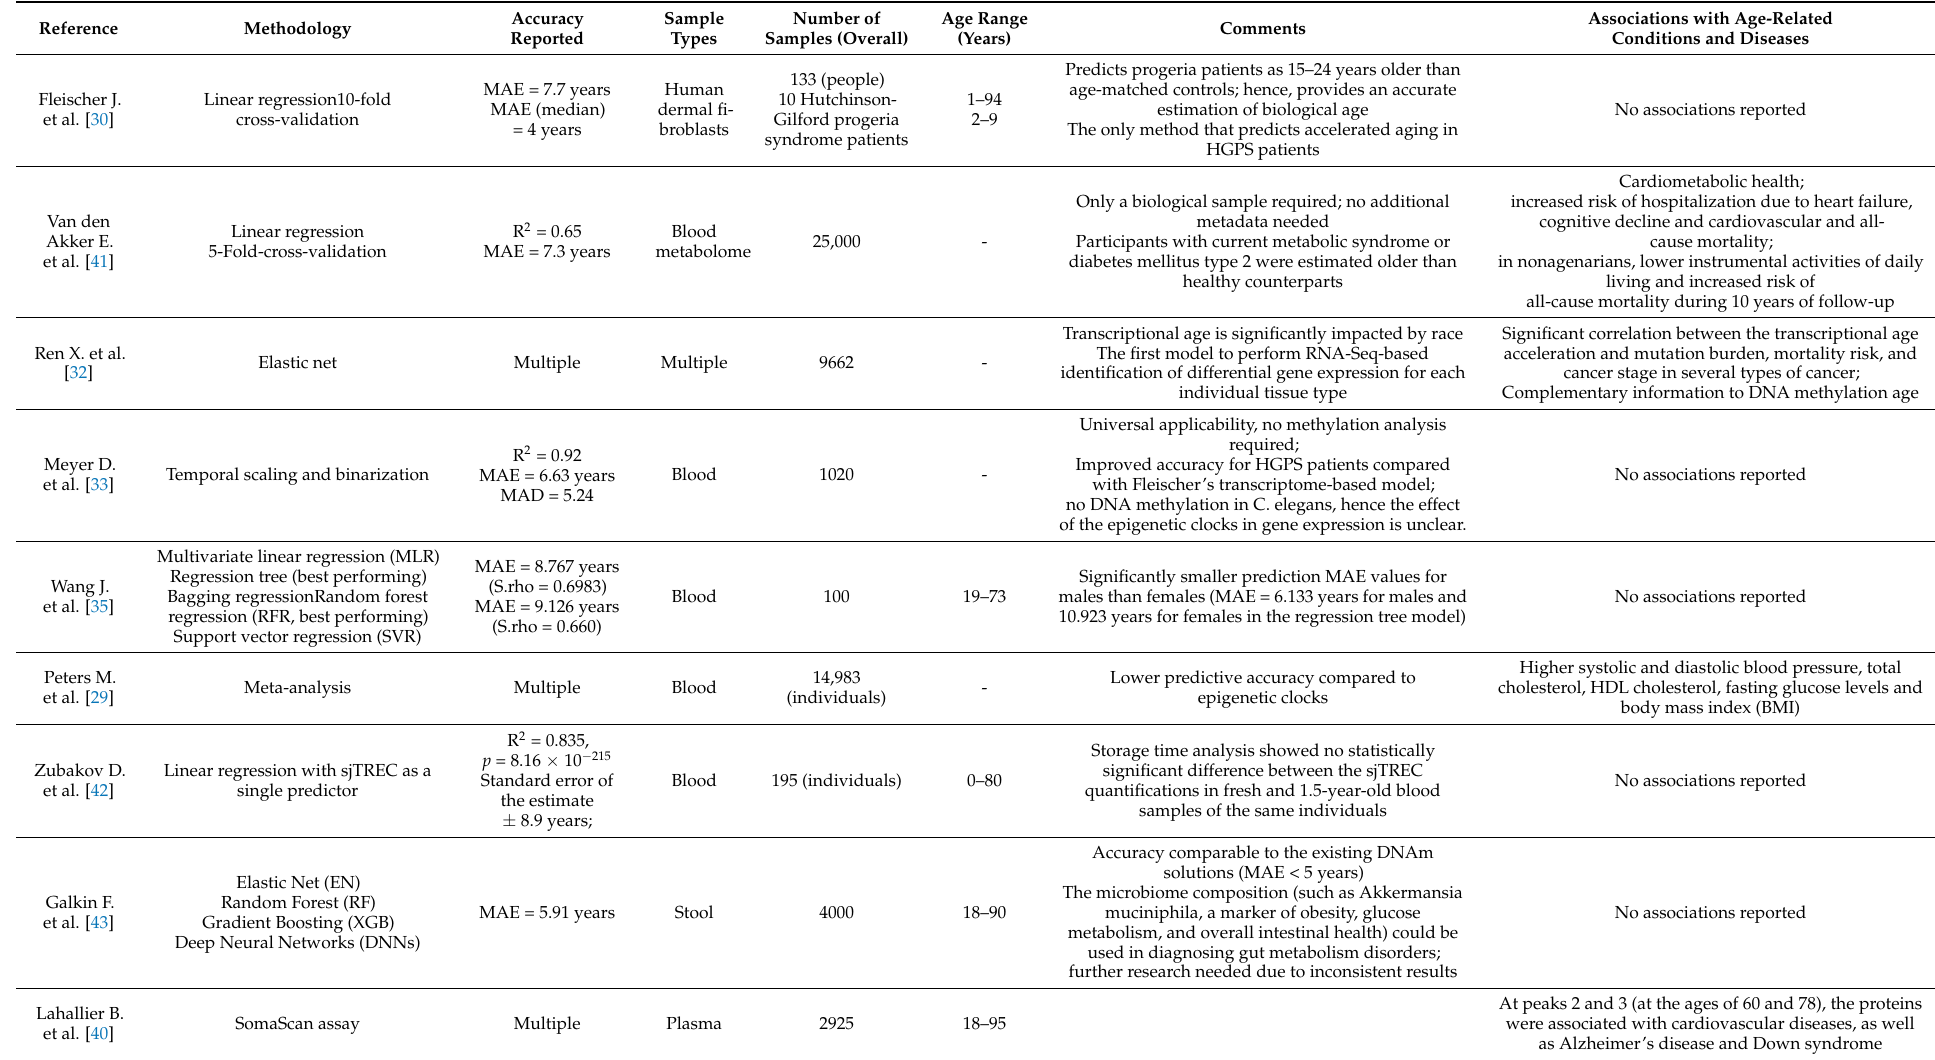
Table 2. Main characteristics of the estimators based on molecular and genetic